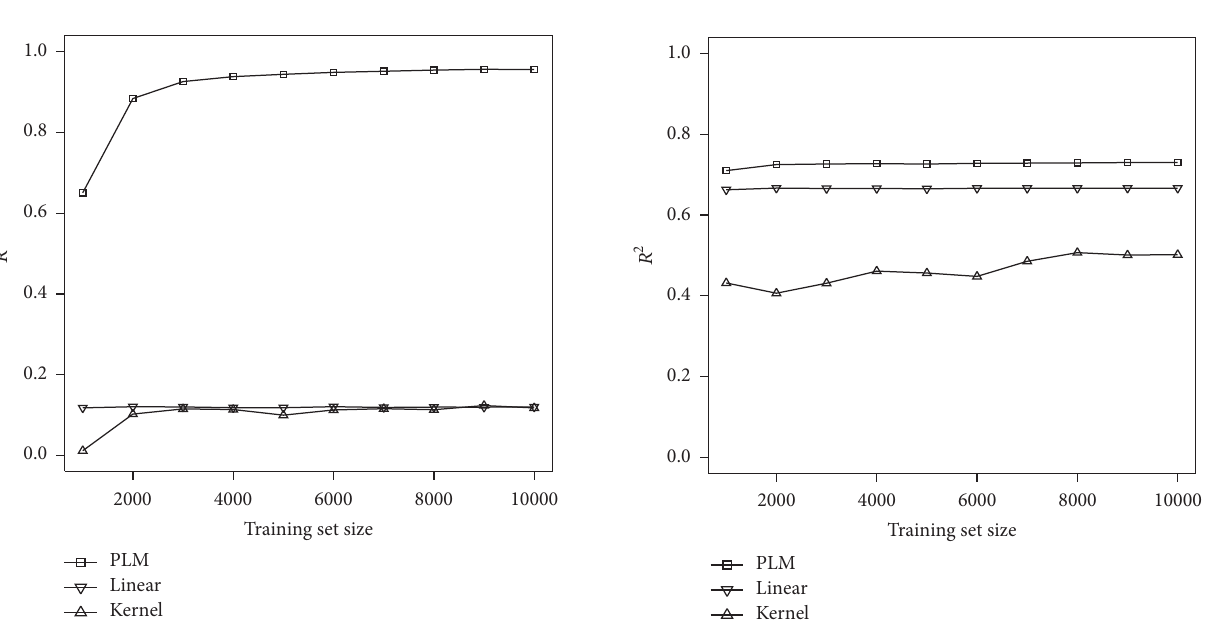
Figure 6: Forecast quality dependence on training set size for airlines data.